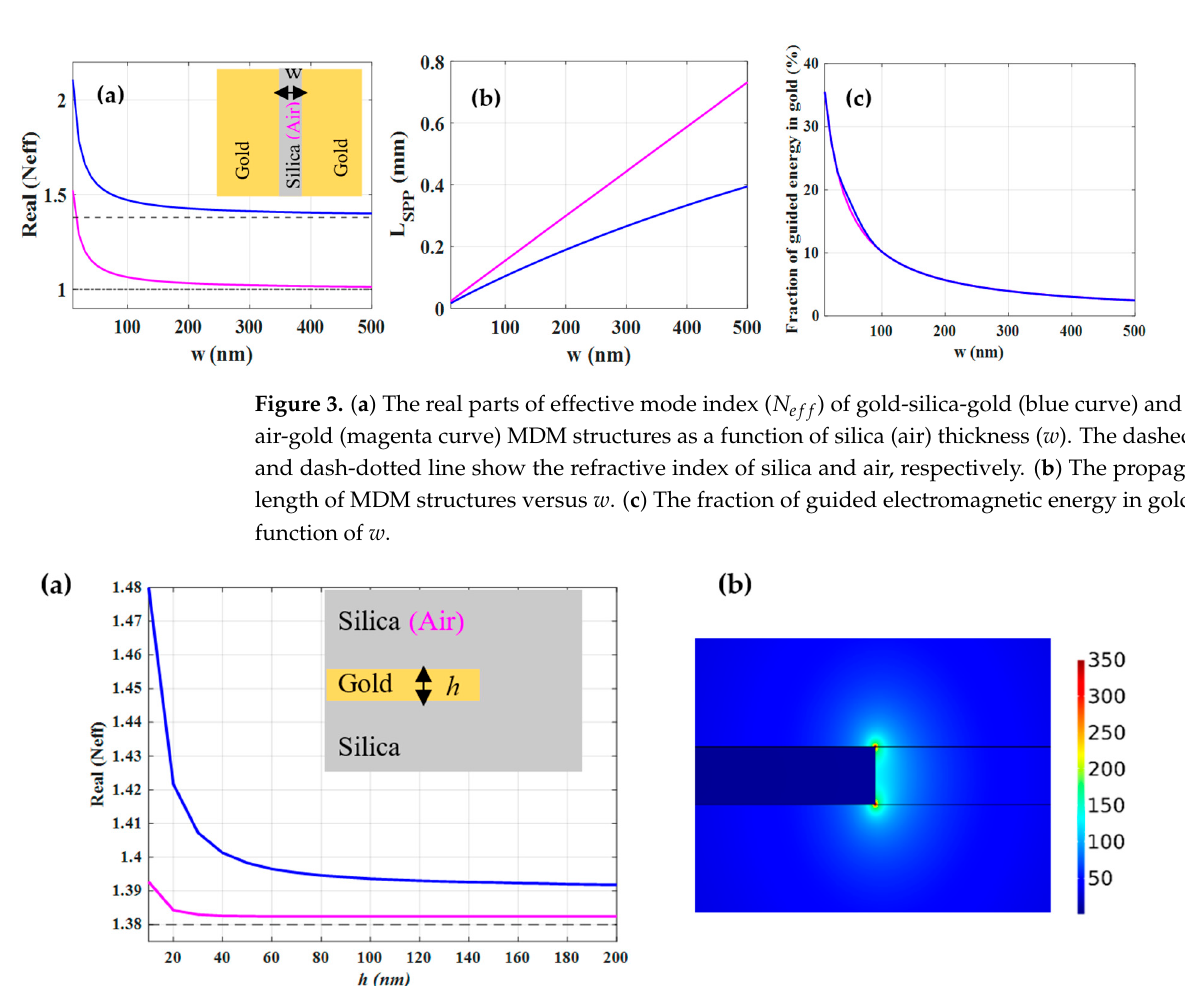
5 of 13 Figure 2. ( a ) The real parts of effective mode index ( 𝑁 (cid:3032)(cid:3033)(cid:3033) ) of symmetric silica-gold-silica (blue curve) and asymmetric air-gold-silica (magenta curve) DMD structures as a function of gold thickness ( h ). The dashed line and the dash-dotted line show the refractive index of silica and the effective mode index of a single silica-gold interface. ( b ) Propagation length ( L SPP ) of DMD structures versus gold thickness. ( c ) The fraction of guided electromagnetic energy in gold versus h . ( d ) Illustration of the electric field distribution (norm E) for different gold thicknesses for silica-gold-silica (symmetric structure). The lateral and vertical simulation domain sizes in ( d ) are 1 mm and 200 µm, respectively. Blue regions correspond to low field intensities and red regions to larger intensities. 4.2. Analysis of MDM Plasmonic Structure The 𝑁 (cid:3032)(cid:3033)(cid:3033) of the guided mode of both, gold-silica-gold and gold-air-gold MDM structures has been indicated in Figure 3a. Like for the DMD structures, the 𝑁 (cid:3032)(cid:3033)(cid:3033) of MDM structures have a higher value as w decreases. In addition, 𝑁 (cid:3032)(cid:3033)(cid:3033) asymptotically ap- proaches the refractive index of the dielectric region (silica or air) as w increases indicating the concentration of the field energy in the dielectric region. As shown in Figure 3b, the L SPP of both MDM structures increases with the increase of w because the amount of guided electromagnetic energy inside the gold decreases as depicted in Figure 3c, leading to a decrease of ohmic losses. Although Figure 3c indicates similar behavior for the guided energy in gold for both structures, the L SPP of the gold-silica-gold MDM structure for a given w is lower than that of the gold-air-gold one which is attributed to the absorption loss of silica in particular. A comparison between the L SPP of MDM and DMD structures for a given thickness of the central region shows a smaller L SPP for the MDM structures.